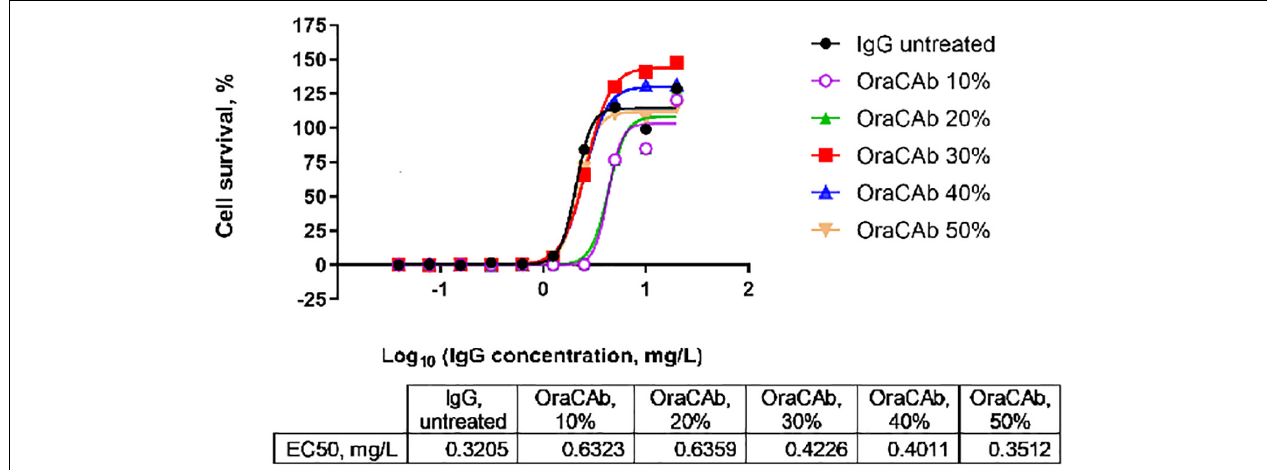
FIGURE 4 | Stability of IgG (anti-TxA4) in OraCAb formulation in SGF. OraCAb was incubated for 2.5 h in SGF at different v/v ratios and full protection of the IgG was found when the volume of OraCAb was 30% (3/10 ratio) or higher compared with the volume of the SGF. Around 50% of the IgG was found inactivated/degraded in SGF containing 10 or 20% OraCAb. Concentrations of IgG in OraCAb that give half maximum inhibition of TcdA in a cell-based toxin neutralization assay (EC 50 ) are given in the table. The calculations were based on the concentration of IgG prior to mixing the formulations with